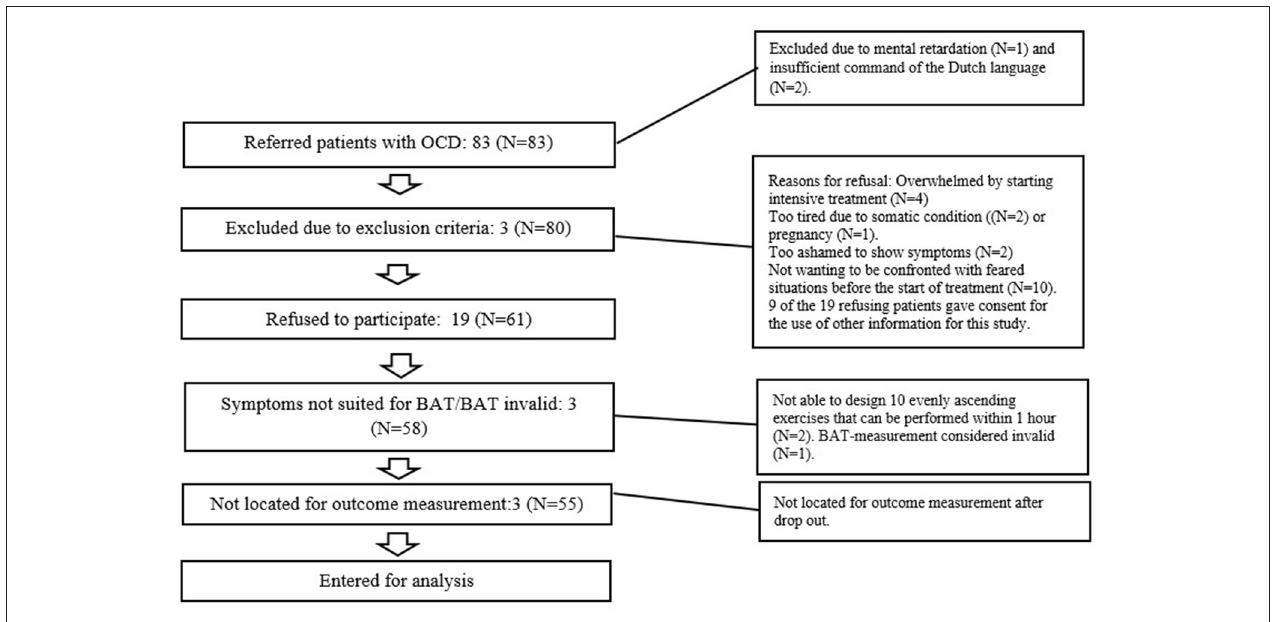
FIGURE 1 | Participant-inclusion from referral to